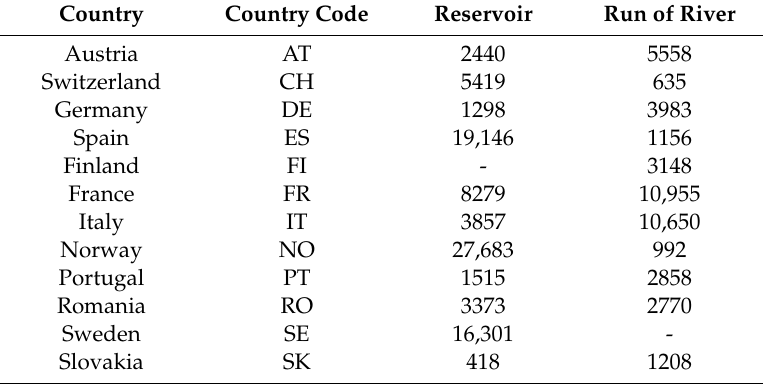
Table 1. List of 12 countries selected in this study with their country code (ISO 3166) and their installed capacities (in MW) in 2019 (from the European Network of Transmission System Operators for Electricity (ENTSO-E) Transparency Platform, accessed on March